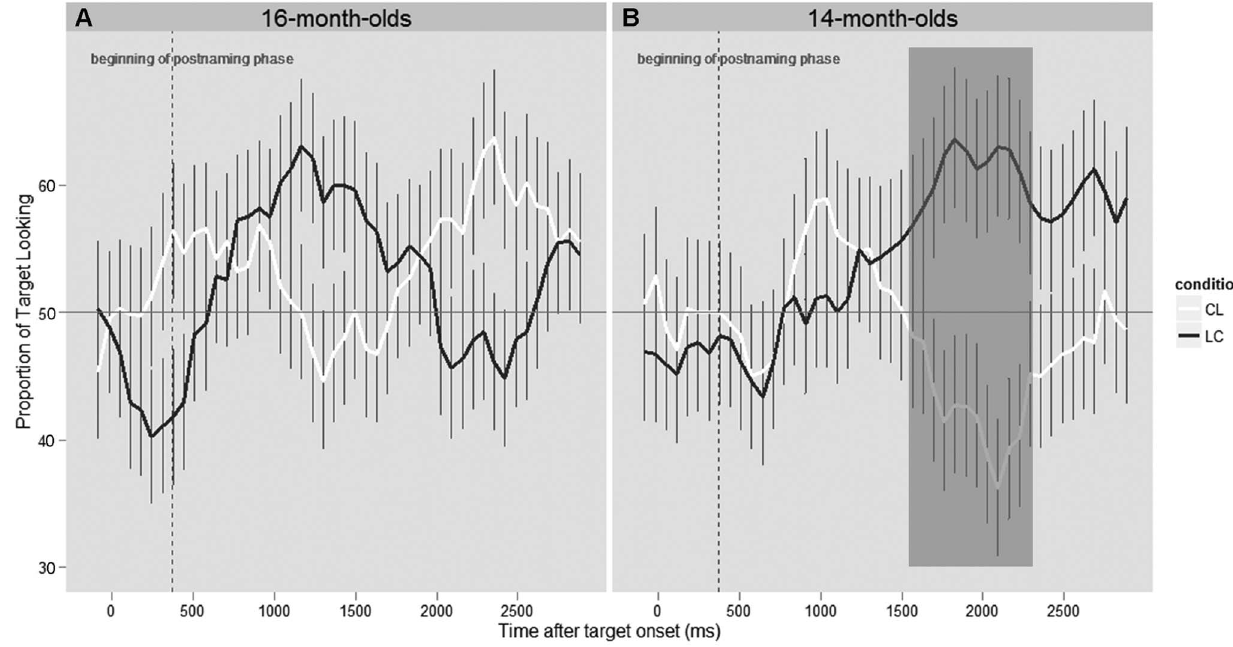
Figure 3. Time course of infants’ target looking behavior during the postnaming phase for LC words (black) and CL words (white) for both 16-month-old infants (Experiment 1, Fig. 3A) and 14-month-old infants (Experiment 2, Fig. 3B). The shaded box indicates the time period in which significant differences between the LC and CL conditions were found.